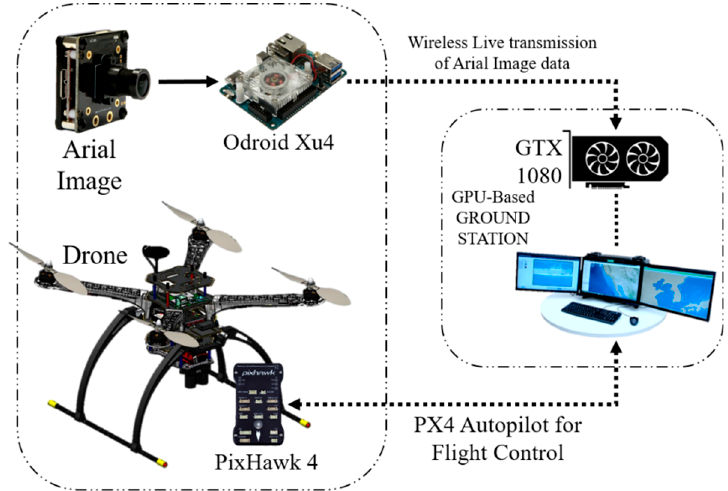
Figure 6. Target detection using the GPU-based ground station from an aerial